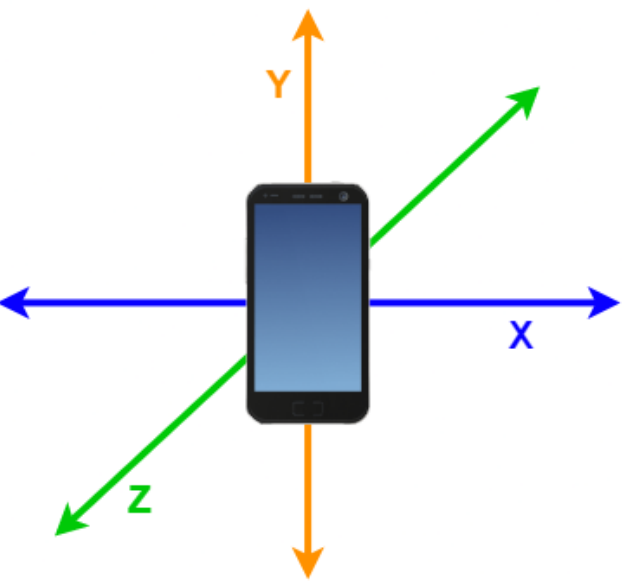
Figure 19. Orientation of the smartphone in the 3D reference space. In order to test this use case, a trial drive was performed mostly on a highway road where large speed humps were located at the beginning and at the end of the trip. Figure 20 shows the evolution of the acceleration of the smartphone in each axis during this trial.